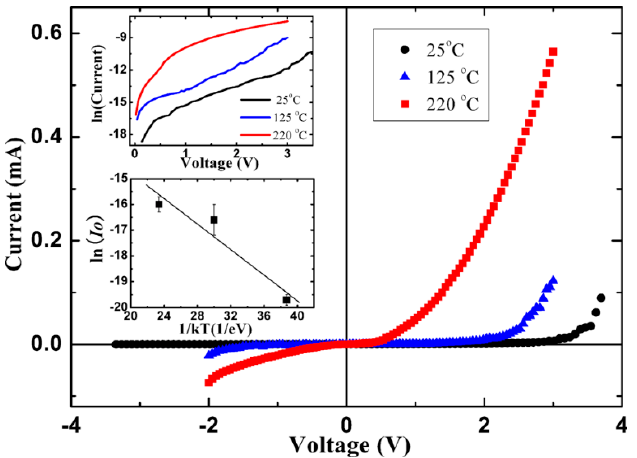
Figure 15. I-V plots of n-ZnO NRs/p-BDD heterojunction at the temperatures of 25 °C, 125 °C and 220 °C. The inset of the top presents the curve of the ln ( I )- V . The bottom inset shows the ln ( I S ) vs. 1/ kT curve